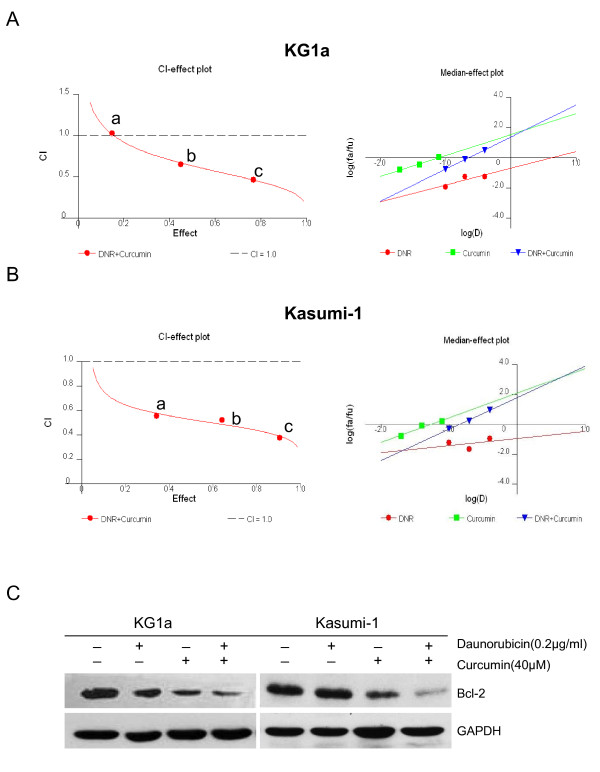
Curcumin synergistically enhanced the cytotoxic effects of DNR associated with down-regulation of Bcl-2. KG1a and Kausumi-1cells were exposed to different concentrations of curcumin, DNR, or their combination as indicated, for 48 h. (A, B) CI-effect plots and median-effect plots were generated using CalcuSyn software. The points a, b, and c represent CI values for the combinations 20, 40, and 80 μM curcumin with 0.1, 0.2, and 0.4 μg/ml DNR in a constant ratio, respectively. The CI values at ED50, ED75, ED90 were 0.667, 0.490, and 0.364 for KG1a cells and 0.529, 0.456, and 0.394 for Kasumi-1 cells, respectively. (C) Bcl-2 protein levels were determined by Western blotting assay. Three independent experiments were performed with similar results, and representative data are shown.